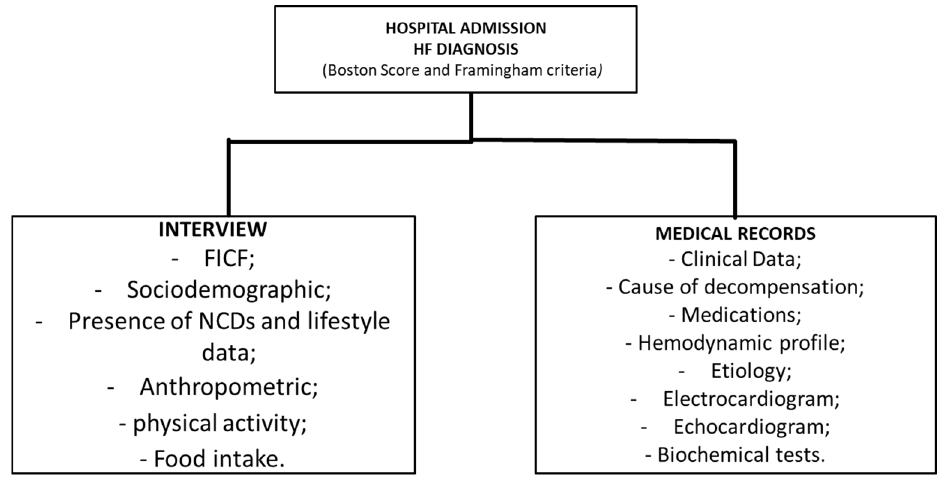
Figure 1. Data collection flowchart. HF—Heart failure; FICF—free and informed consent form;